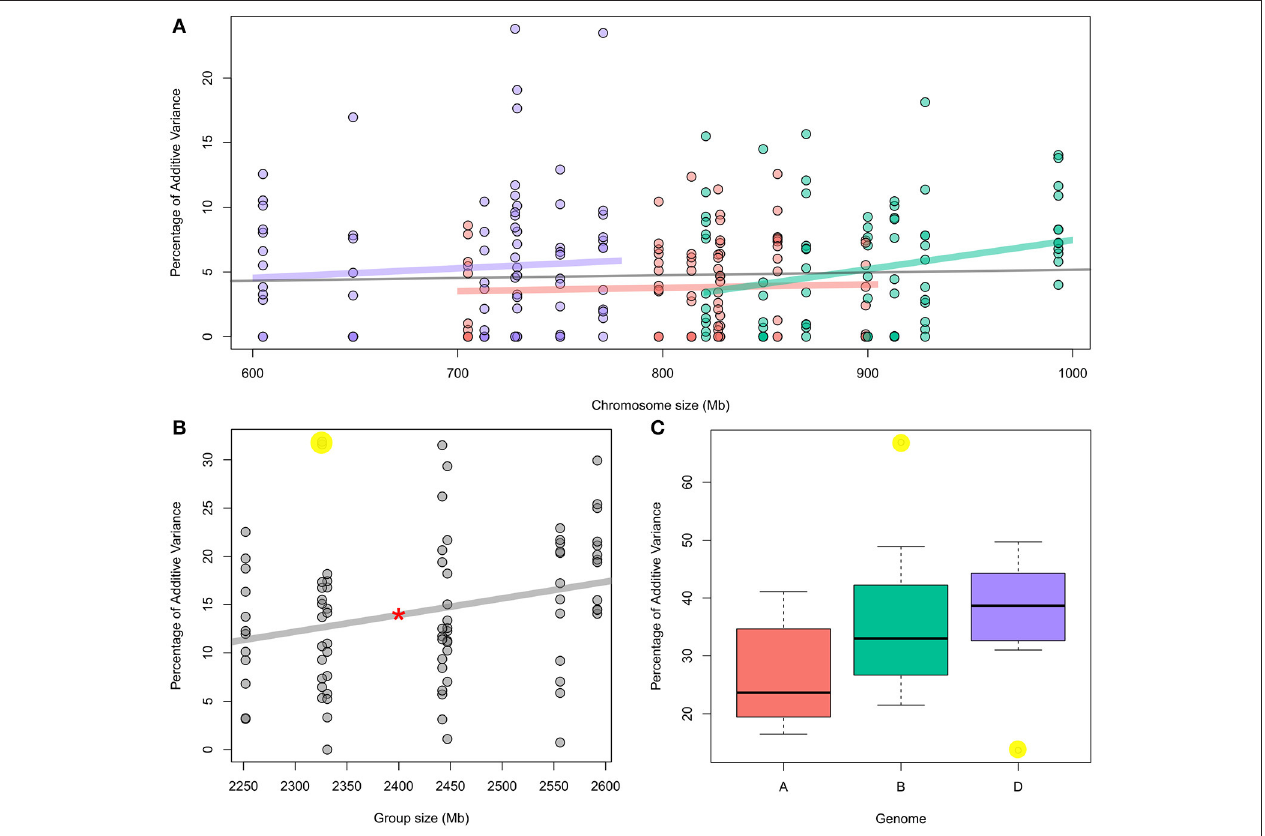
FIGURE 1 | (A) Percentage of individual chromosome contribution to the additive variance of 12 traits as function to chromosome size; red: “A” genome chromosomes; Green: “B” genome chromosomes; and Purple: “D” genome chromosomes. The gray line represents the correlation for all 21 chromosomes. For individual traits, see Figure S1 . (B) Percentage of each chromosomal group (seven groups) contribution to the additive variance of 12 traits as function to chromosome size. Red star over the correlation line represents its significance at P < 0.05. For individual traits, see Figure S2 . (C) Boxplot showing the contribution of each genome to the additive variance of 12 traits. Highlighted yellow dots in b and c represent the outliers. For detail information, see Table 1 .